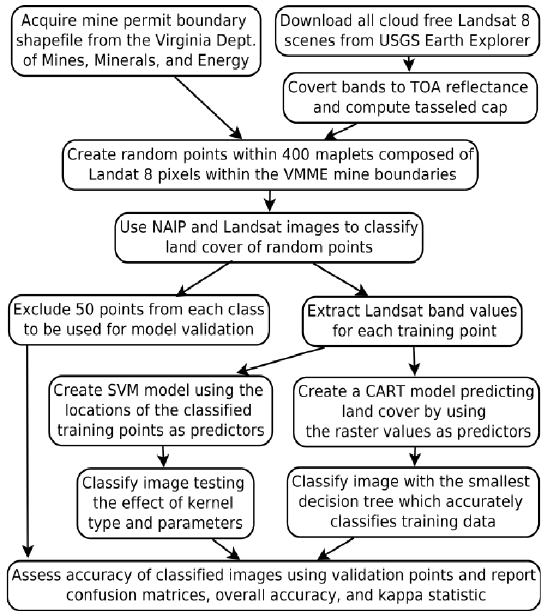
Figure 3. Flow diagram outlining the input data and processing steps used to generate models for presence or absence of autumn olive for the study area.